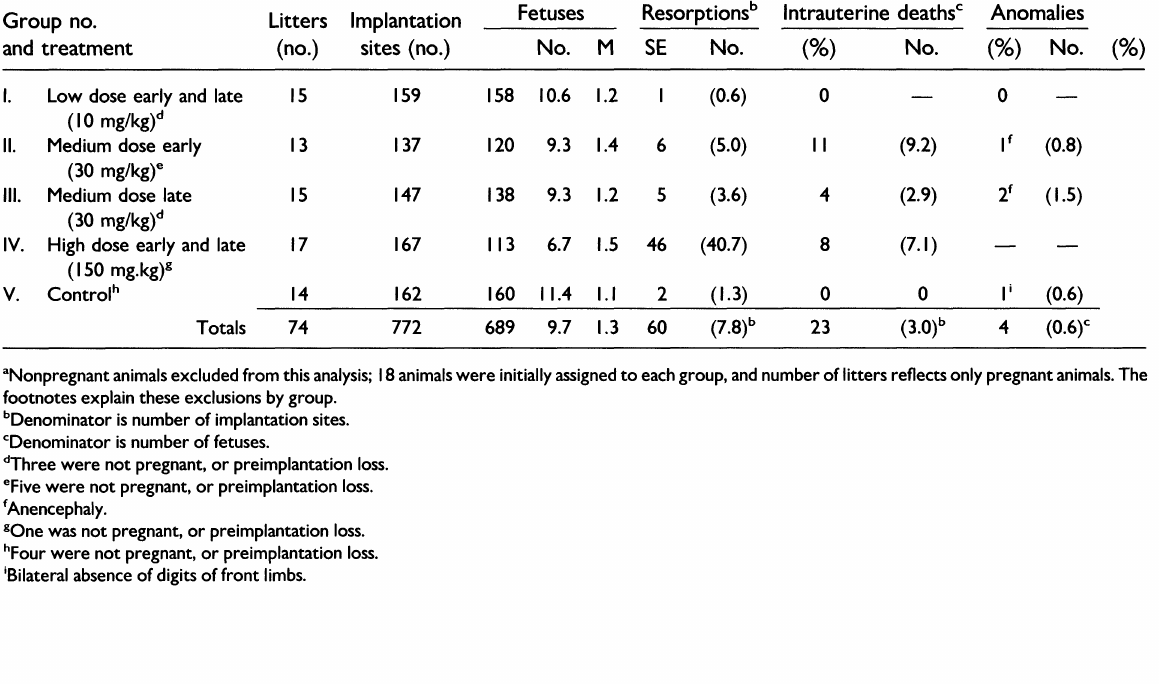
TABLE I. Pregnancy outcome in zidovudine-treated and control rats Group no. Litters Implantation Fetuses Resorptions b and treatment (no.) sites (no.) No. No.